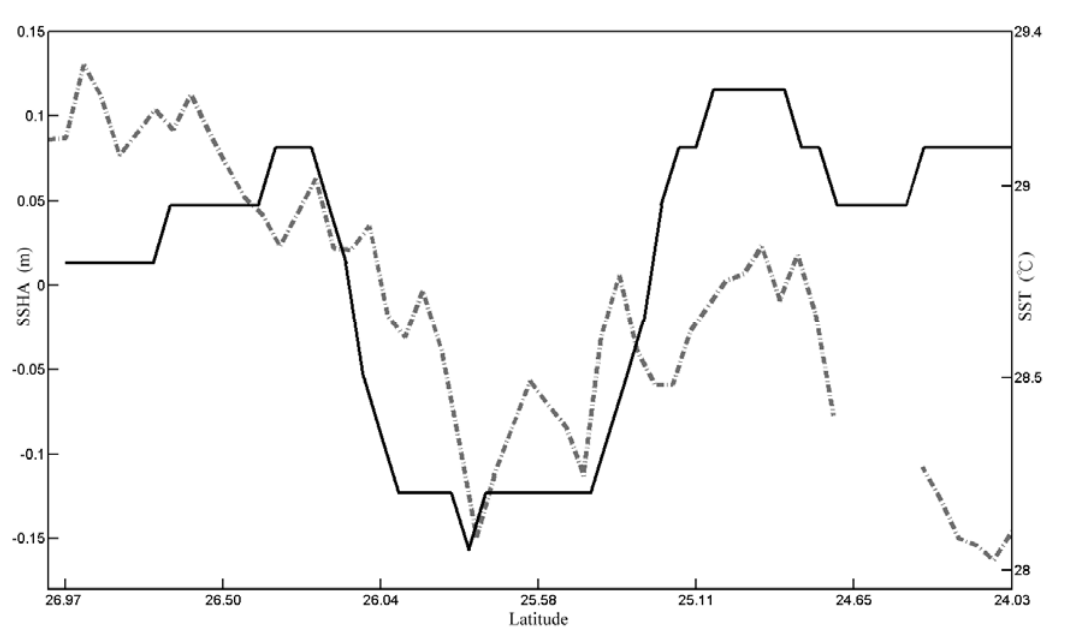
Figure 4. Comparison of Jason-1 sea surface height anomaly on July 28, 2006 (dashed line) and NGSST data on the July 29, 2006 (solid line) along the same transect.